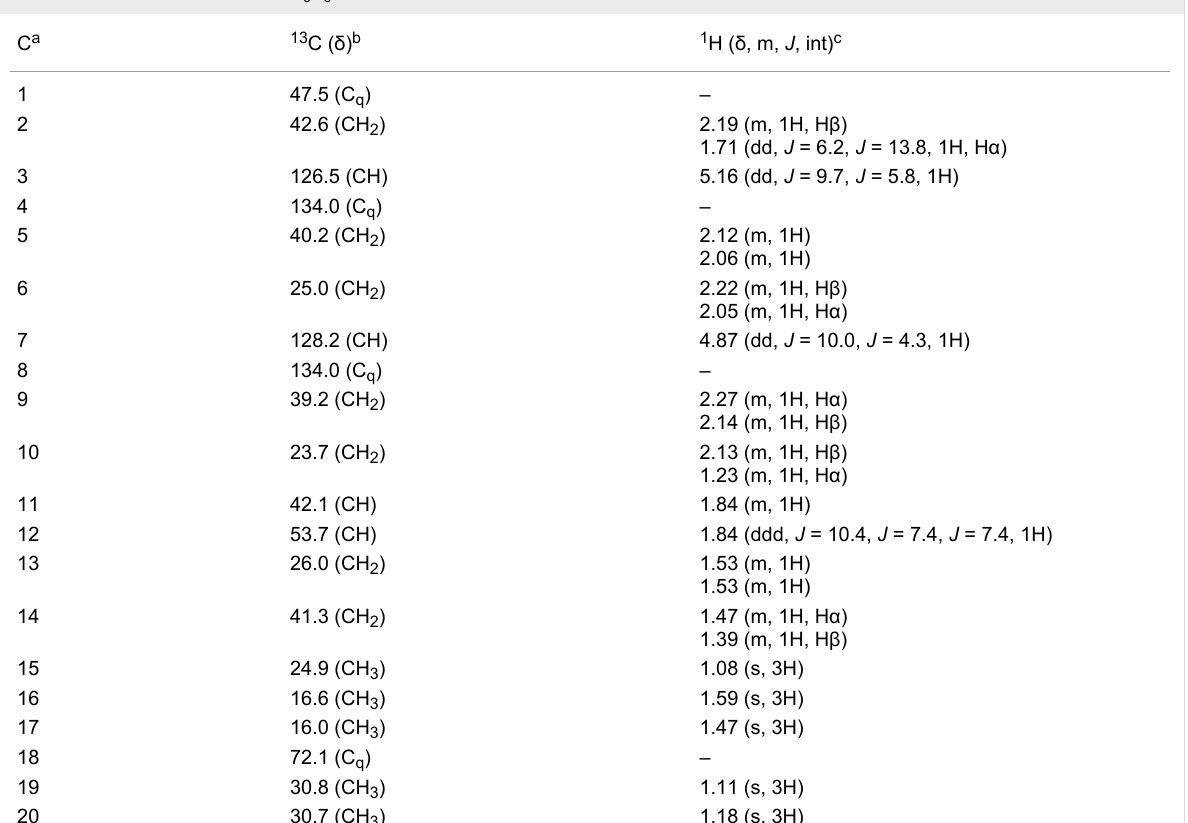
Table 1: NMR data of 3 recorded in C 6 D 6 .